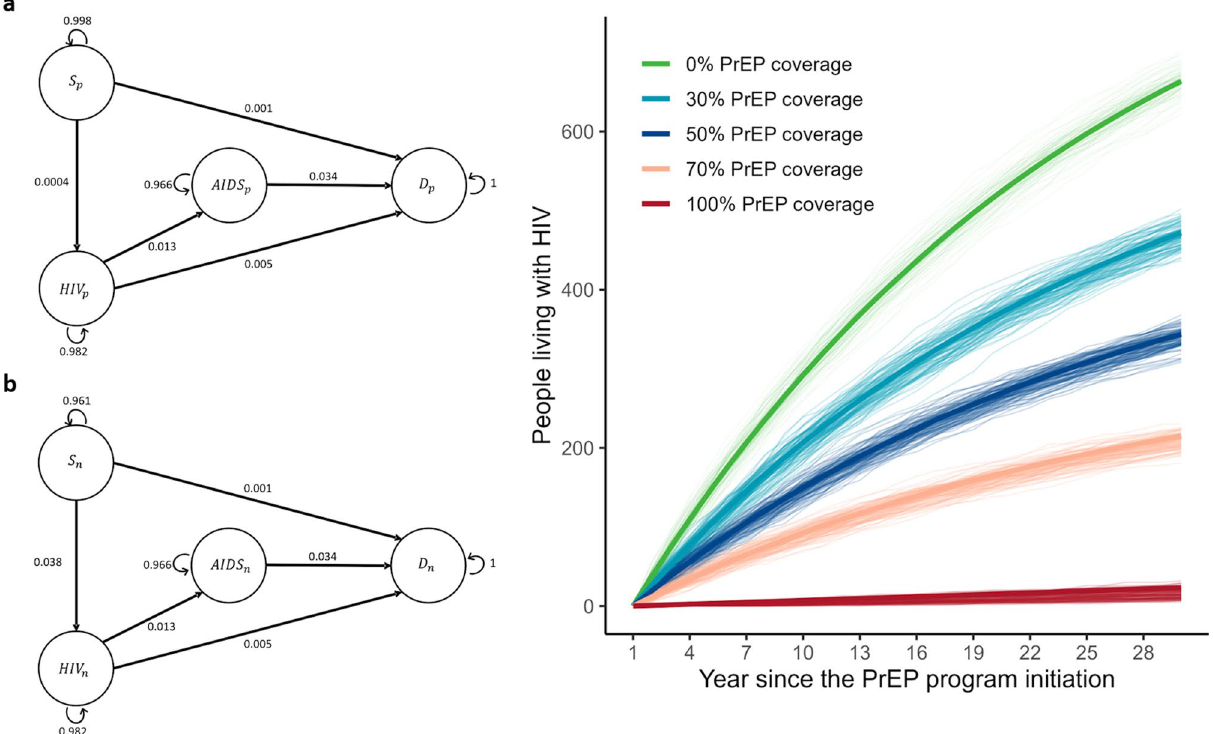
Figure 1. Schematic representation of the Markov model and the impact of pre-exposure prophylaxis (PrEP) on HIV incidence over 30 years. ( a ) The Markov model for individuals without PrEP (a-1) and with PrEP (a-2). Four different health status groups of infection and disease progression were considered: susceptible and uninfected (denoted by S ), HIV-infected without AIDS ( HIV ), HIV-infected with AIDS ( AIDS ), and dead ( D ). The four health conditions were further annotated by PrEP status (e.g., S with and without PrEP denoted by S p and S n , respectively). Arrows represent transitions between different states, and the numbers are transition probabilities. ( b ) Short-term impact of a PrEP program on the MSM cohort. The thin lines represent the results of 100 simulations for illustration purposes, and the solid lines represent the mean of 1000 simulations. The number of people living with HIV (i.e., individuals categorized in one of the four health status groups: HIV p , HIV n , AIDS p , AIDS n ) in a given year after initiation of the PrEP